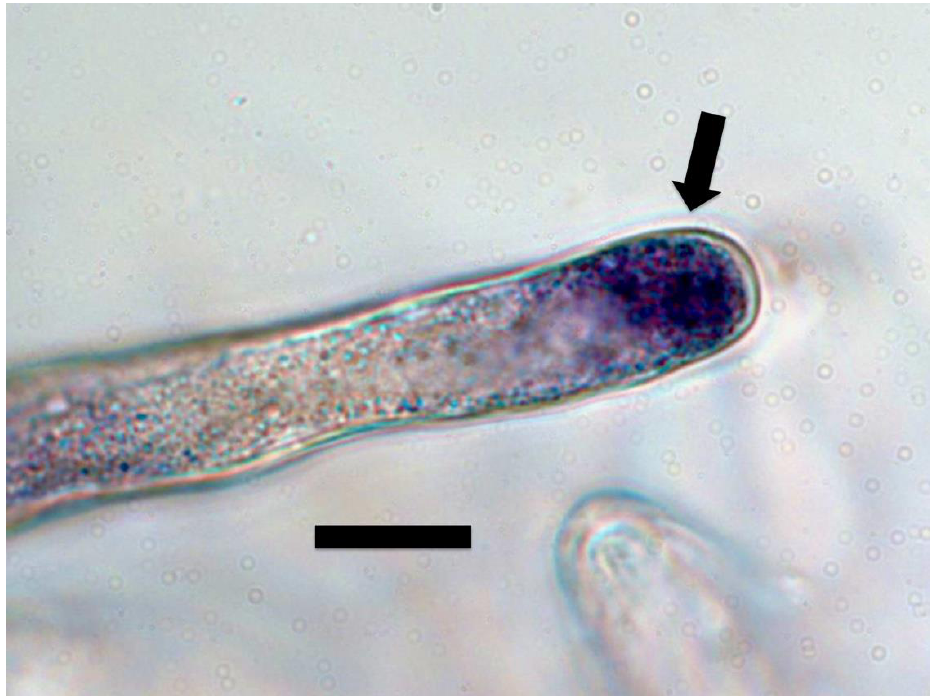
Figure 5. Tall fescue seedling root hair stained with 0.1% nitro blue tetrazolium showing superoxide (purple color) around bacterial protoplasts at the hair tip (arrow; bar = 15 µm).